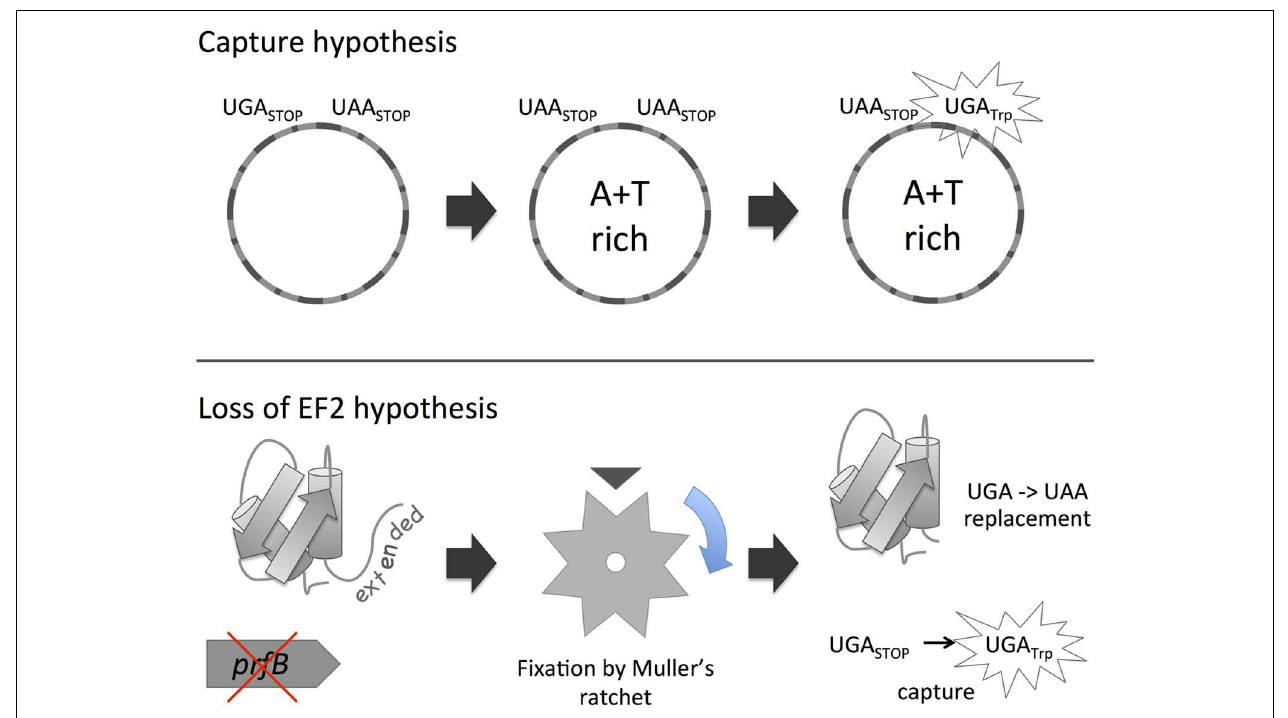
FIGURE 4 |The reassignment of stop codon (UGA stop ) to code for tryptophan (UGA Trp ) is explained using the “capture hypothesis.” However, the large G + C content in “ Ca . Hodgkinia cicadicola” makes the